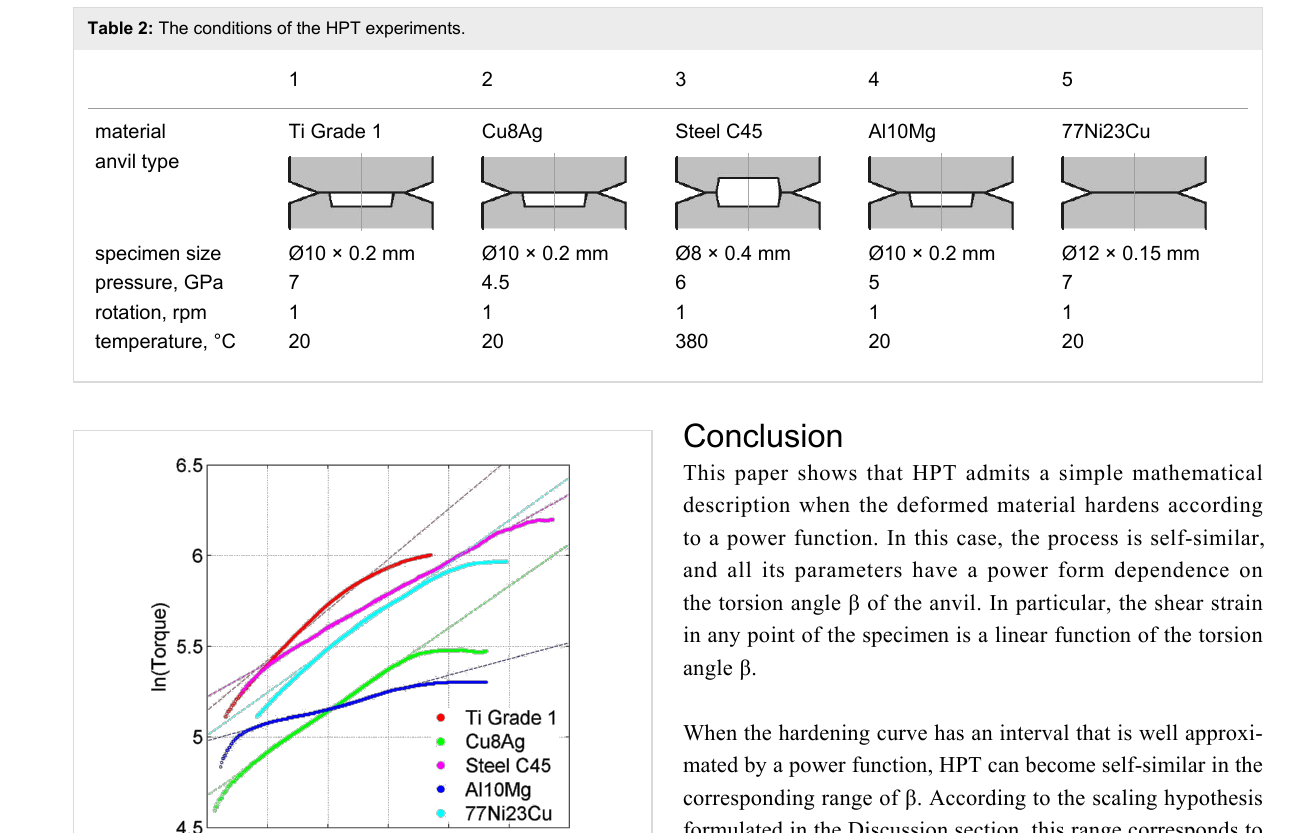
In the scaling ranges in Table 2, the slope n of the tangent line is equal to the exponent of the hardening curve, while the shear strain in any point of the specimen is given by the formula: